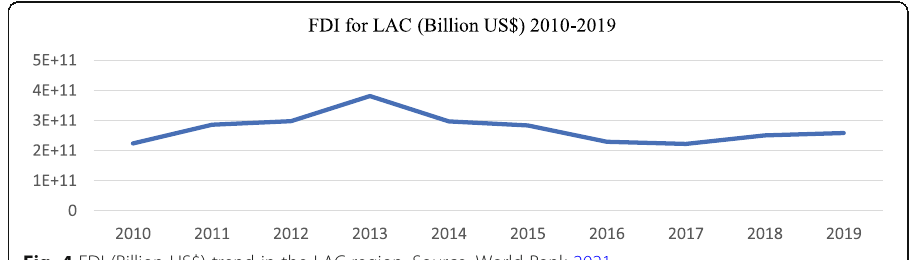
Fig. 4 FDI (Billion US$) trend in the LAC region. Source: World Bank